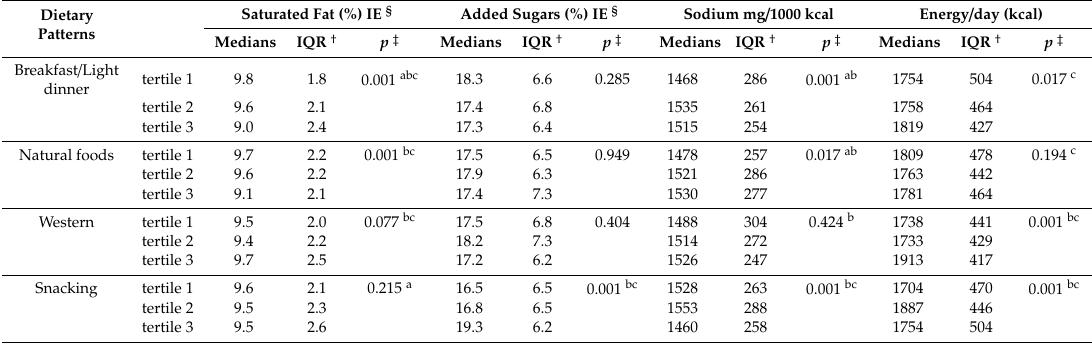
Table 4. Medians nutrient intake according to tertile † of adherence to dietary patterns in GOCS adolescents ( n :882).